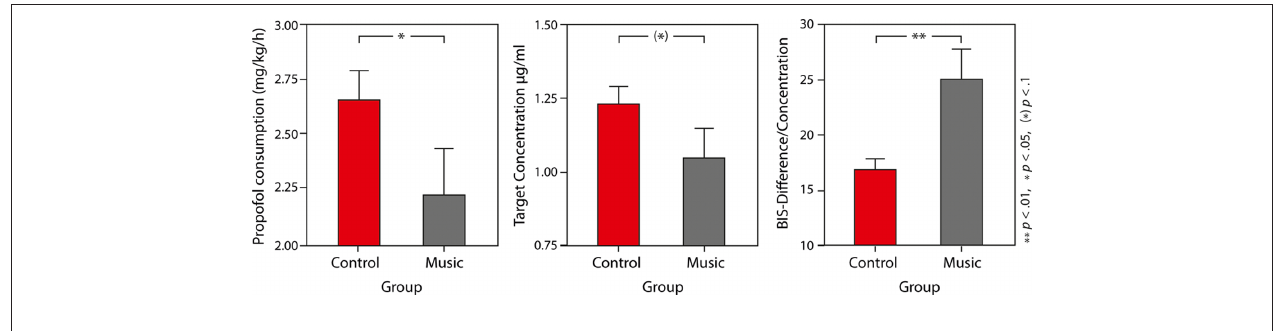
FIgure 2 | Average propofol consumption (left panel), target propofol concentration (middle panel), and propofol concentration relative to the BIS-value (100–BIS-value/concentration, right panel), separately for the